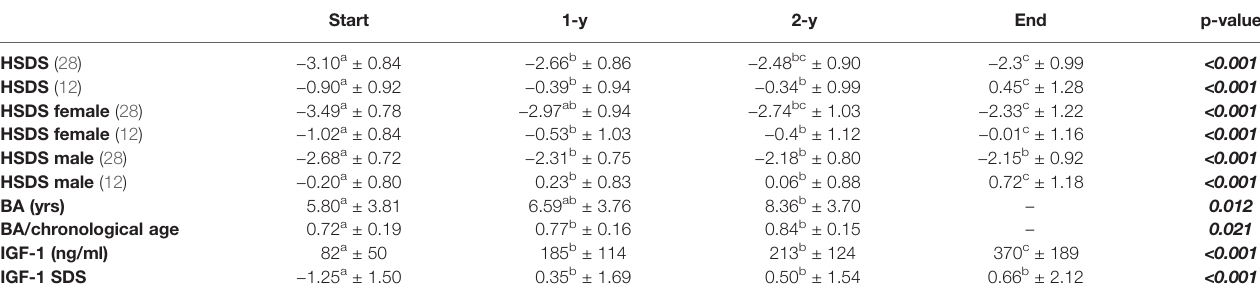
TABLE 2 | Auxological features and IGF-1 levels of NS subjects during rhGH